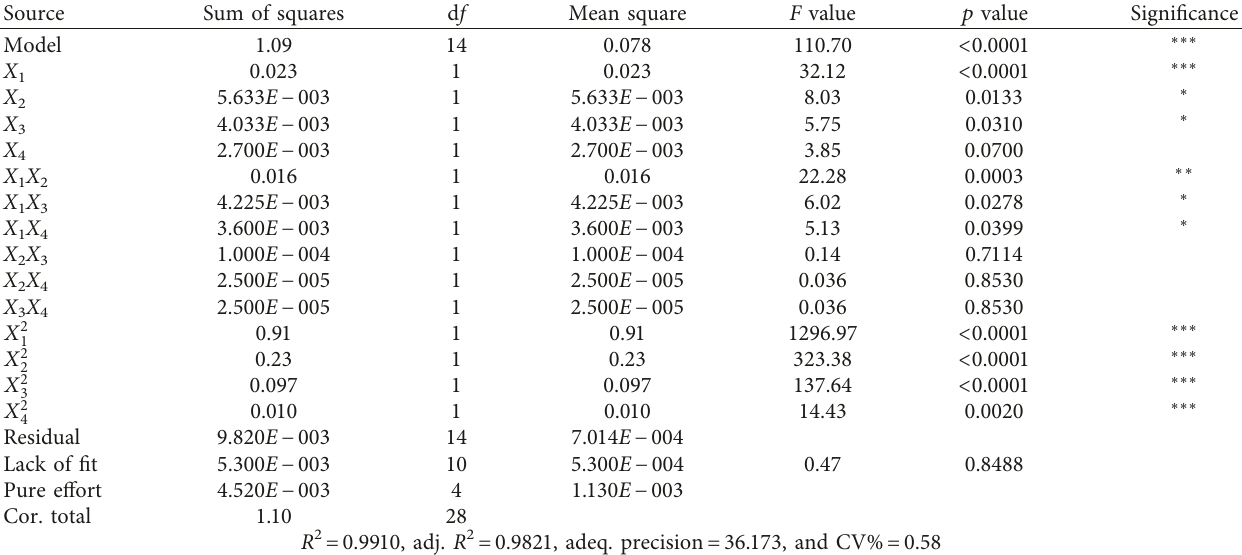
Table 3: ANOVA of the predicted regression model for